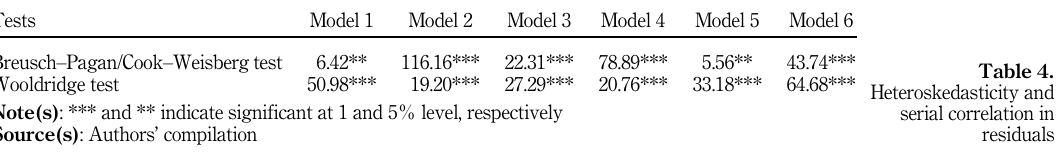
Table 4. Heteroskedasticity and serial correlation in